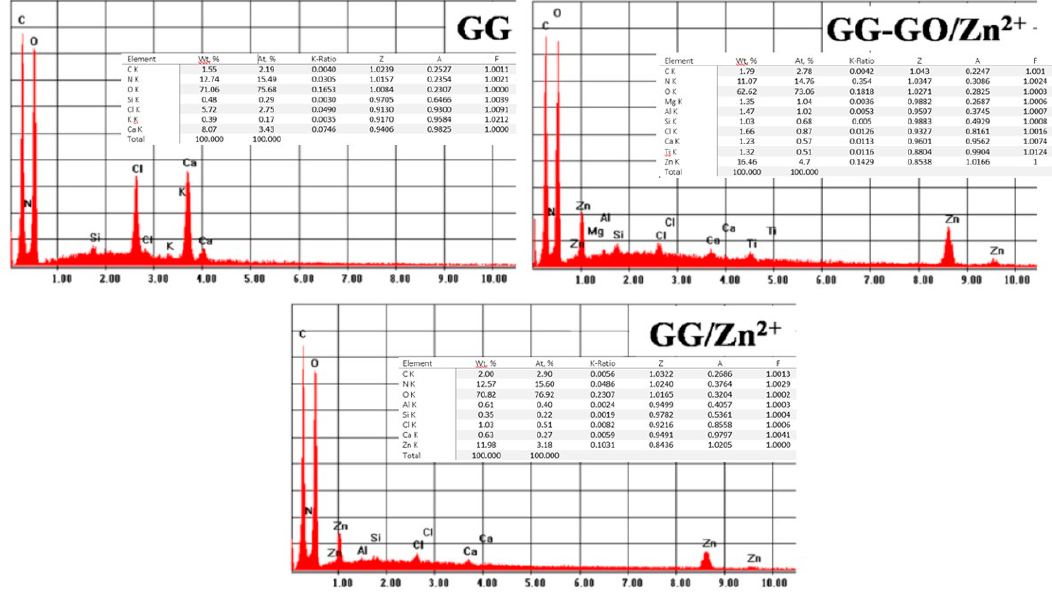
Figure 7. Energy dispersive X-ray analysis (EDAX) spectra of GG and GG/GO beads before and after Zn (II) sorption.